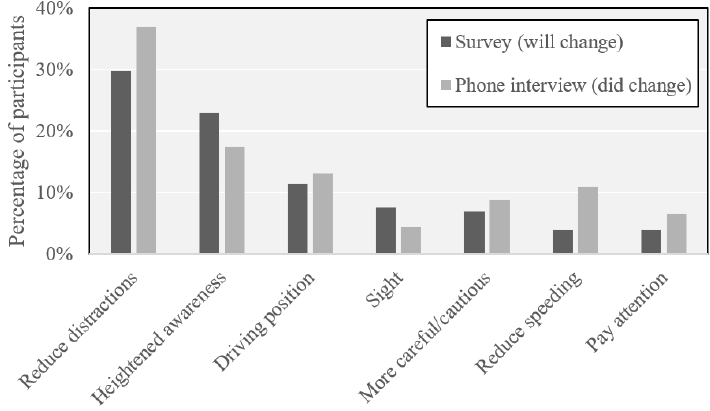
Figure 12. Topical areas for the change in driving behaviors: survey vs. phone interview.